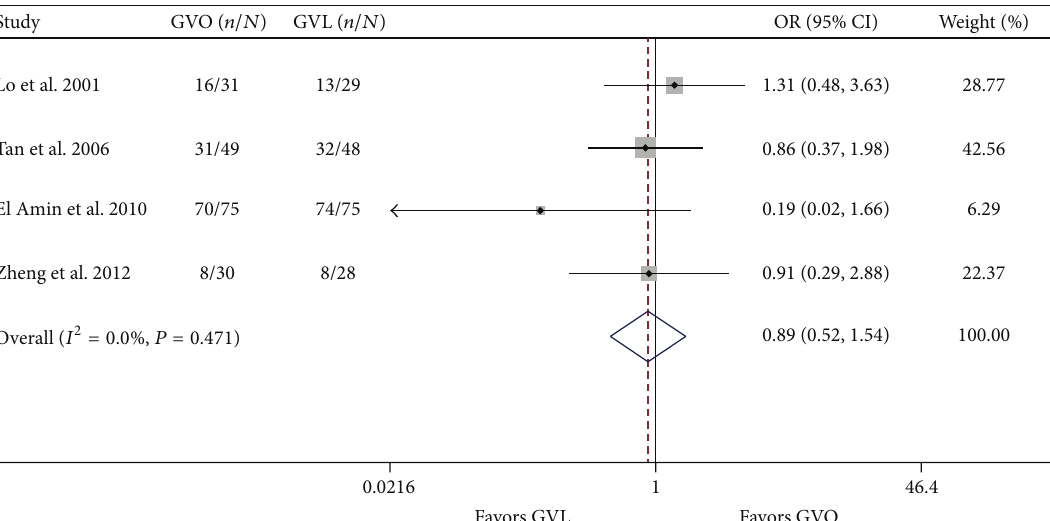
Figure6:ComparisonofvaricealobliterationintheGVOandGVLgroups.GVO,cyanoacrylateinjection;GVL,bandligation;CI,confidence interval; OR, odds ratio.